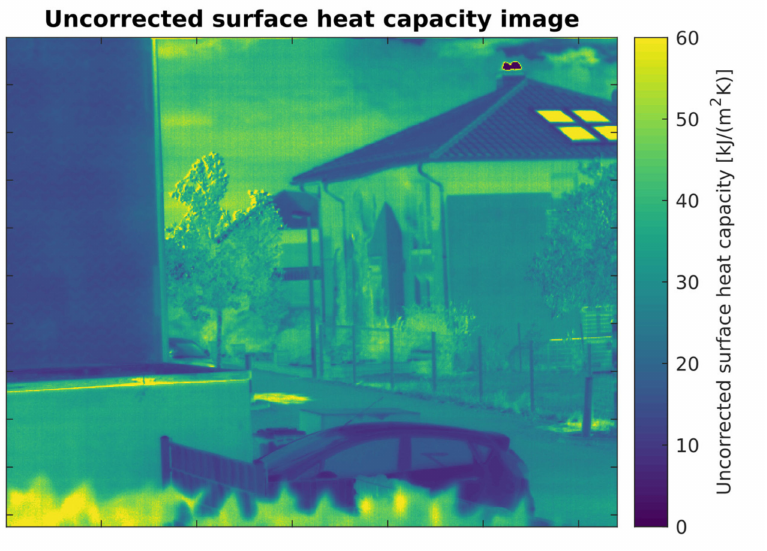
Figure 7. Surface heat capacity